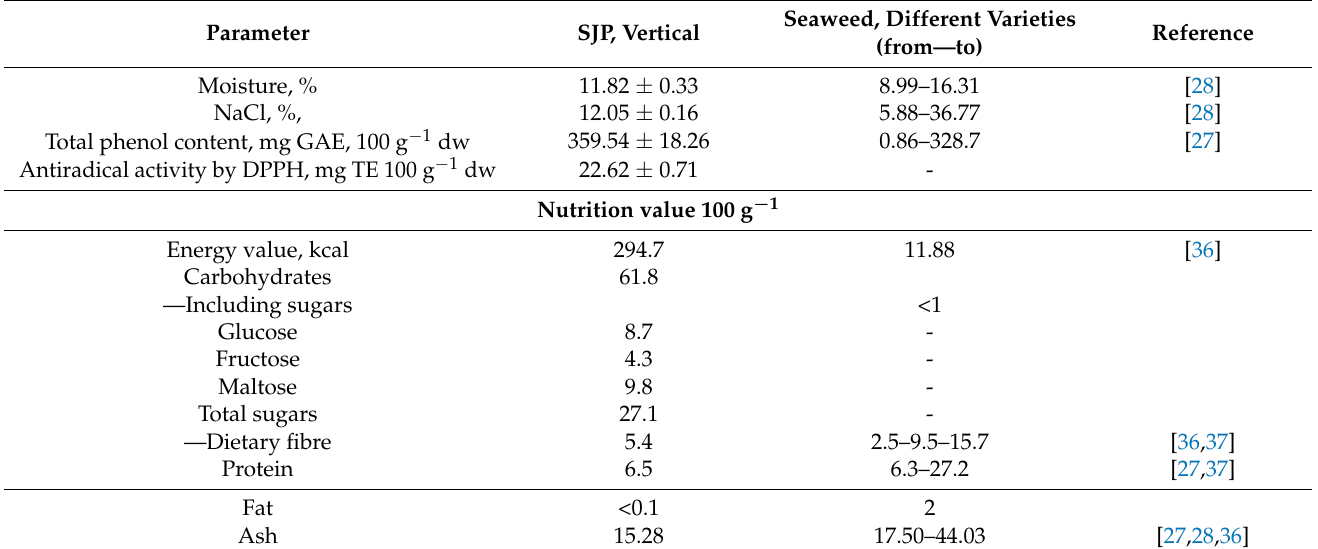
Table 2. The physico-chemical and nutritional value of vertically spray-dried sauerkraut juice and dried seaweed 100 g − 1